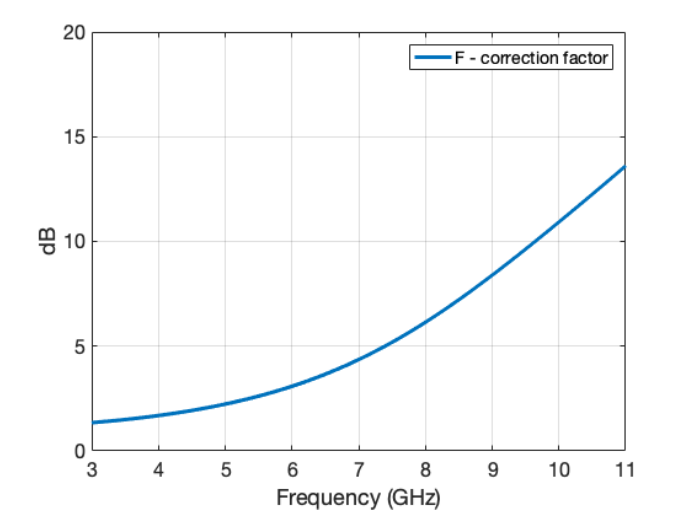
Figure 8. The F correction